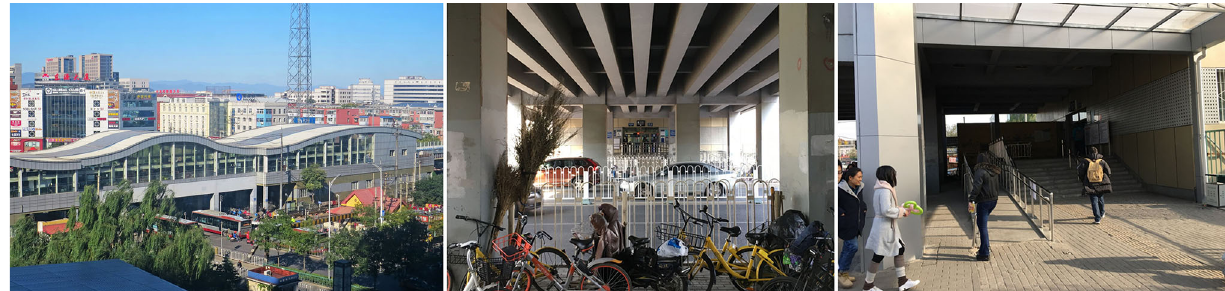
Fig. 1 Left—urban context of WDK station; middle—the roadway and sidewalks beneath the station; and right—the entrance to